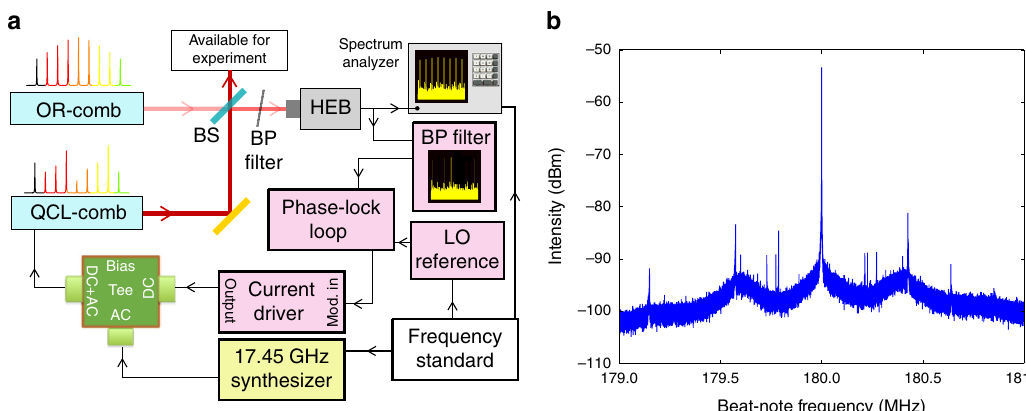
Fig. 1 Experimental set-up. a Schematics of the experimental setup employed for full stabilization, control and characterization of the QCL-comb. The beams of the OR-comb and QCL-comb are superimposed by means of a beam splitter (BS) and then mixed on a fast detector (HEB: hot-electron bolometer). The HEB signal is acquired on a spectrum analyzer (Tektronics RSA5106A) while the two stabilization loops act on the QCL bias. The yellow background object represents the RF synthesizer used for injection locking, while the pink background objects are related to offset stabilization through phase-lock loop (BP fi lter: band-pass fi lter, LO reference: local oscillator reference). All the oscillators and the spectrum analyzer are frequency-referenced to the primary frequency standard. b Phase-locked beat-note signal acquired with a 2 MHz span and 10 Hz RBW. The two sidebands indicate a